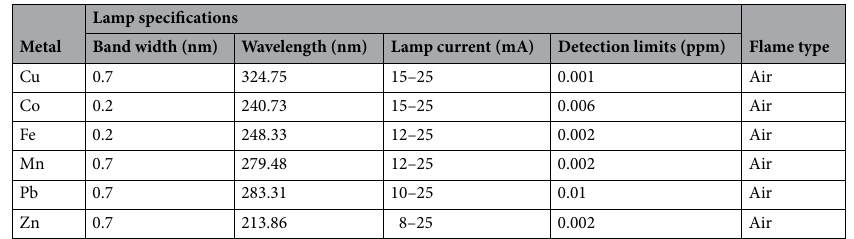
Table 1. Parameters set on the PinAAcle 900H flame/furnace Atomic Absorption Spectrophotometer (AAS).